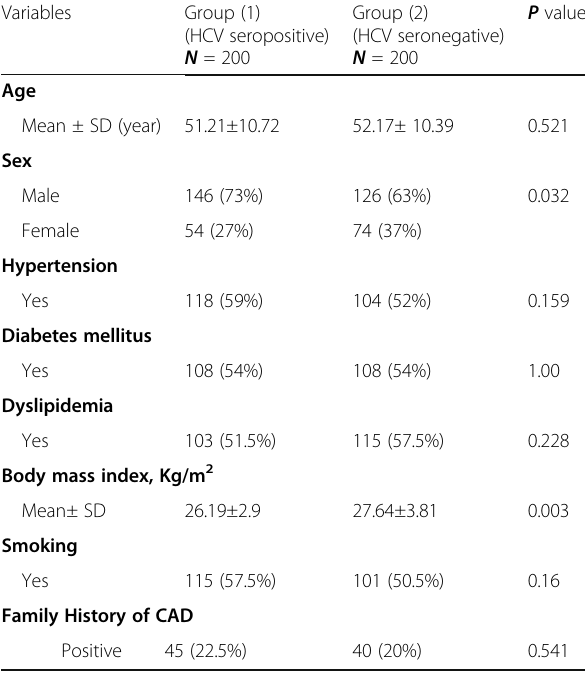
Table 1 Baseline demographics and clinical characteristics